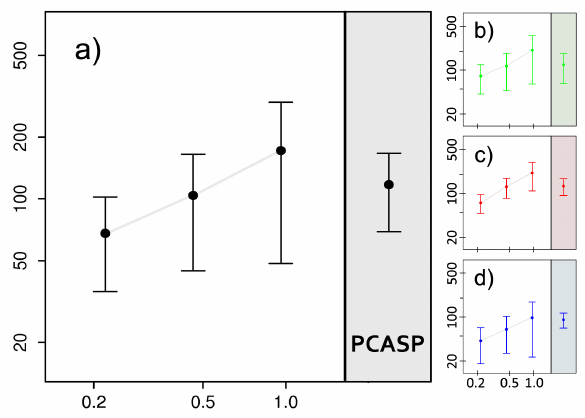
Fig. 7. Plots of N ccn (y-axis; log scale; cm − 3 ) at the CCN instru- ment SS (x-axis; log scale; %) for (a) all King Air horizontal tran- sects, (b) transects through northerly flow, (c) northwesterly flow, and (d) westerly flow. The mean N ccn are marked with filled circles and the error bars represent one standard deviation from the mean. The mean and standard deviation of the PCASP total number con- centration is shown in the shaded region of each plot.